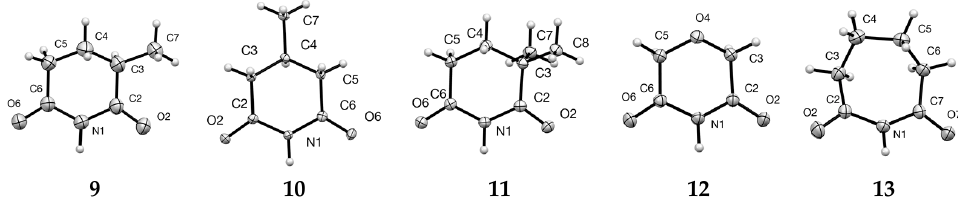
Figure 9. Molecular structures for glutarimides 9–11 , morpholine analogue 12 and adipamide 13 showing numbering systems used (50% probability ellipsoids).